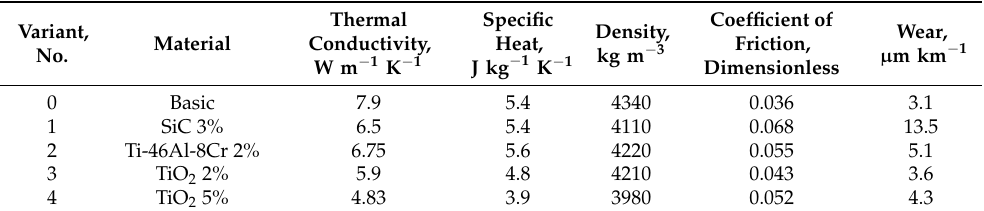
Table 1. Influence of the type of carbon-containing additive on the thermophysical properties and coefficient of friction.